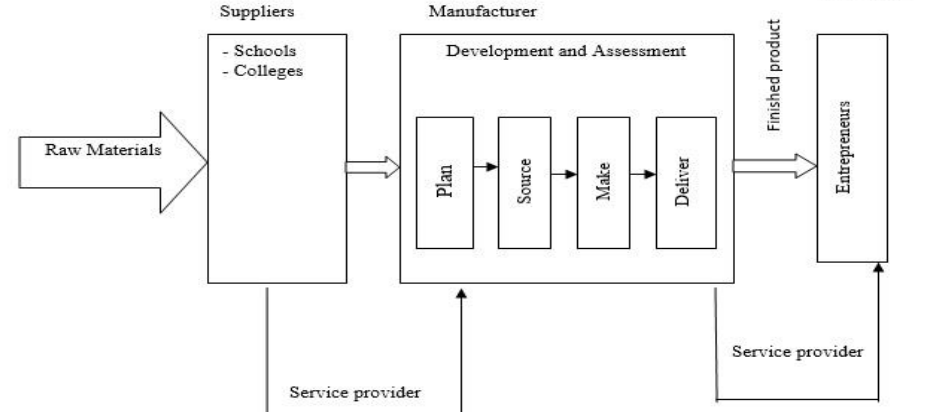
Fig. 2. Information system model for educational management in supply chain for Thai higher education